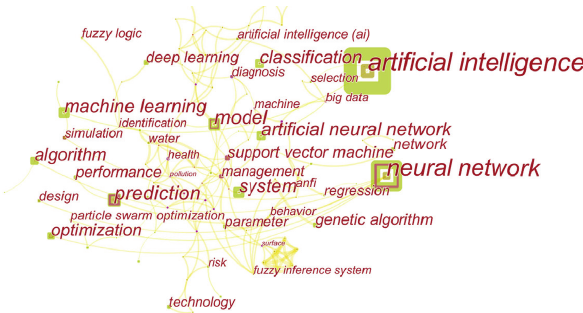
Figure 1: Knowledge graph of AI research